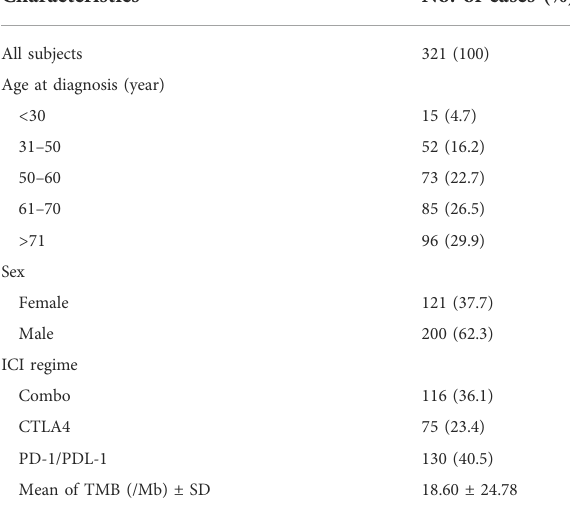
TABLE 1 Clinicopathological characteristics of the MSK-IMPACT metastatic melanoma cohort that underwent ICI treatment.